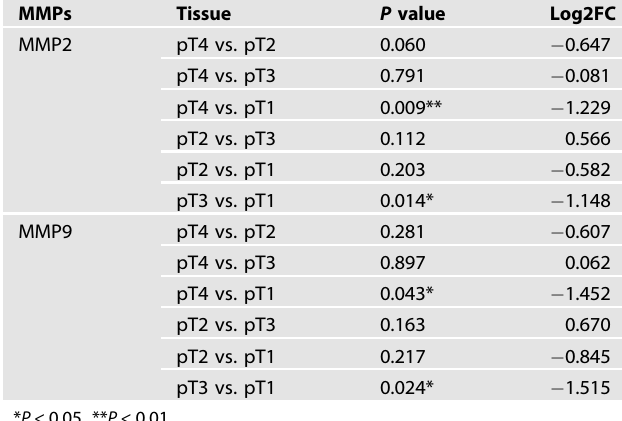
Table 1. Signi fi cant results of association between MMPs and clinical tumor status based on a two-sample t-